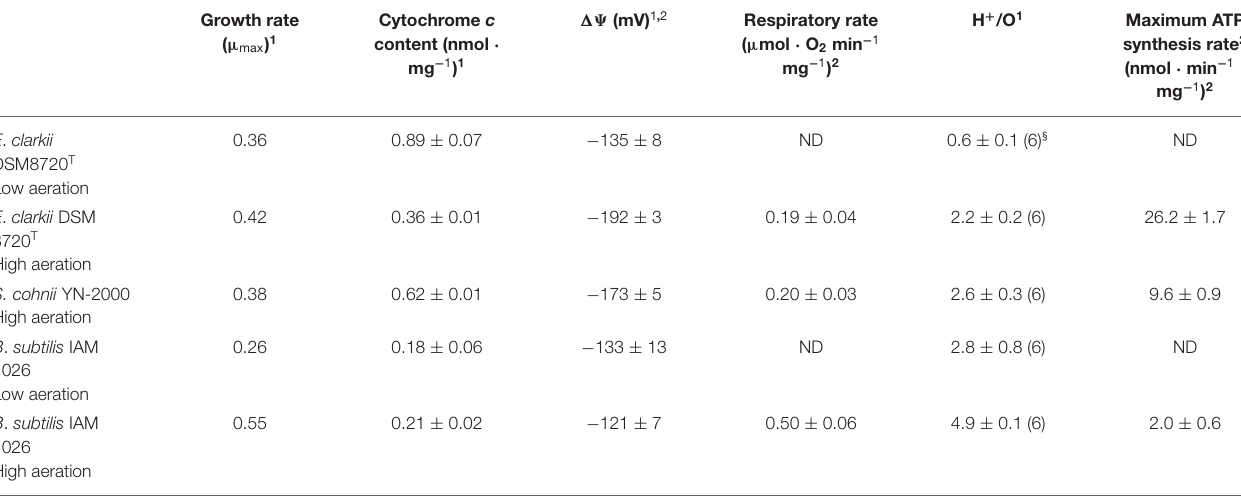
TABLE 2 | Summary for high aeration and low aeration in obligate alkaliphilic Evansella clarkii, facultative alkaliphilic Sutcliffiella cohnii , and neutralophilic Bacillus subtilis *